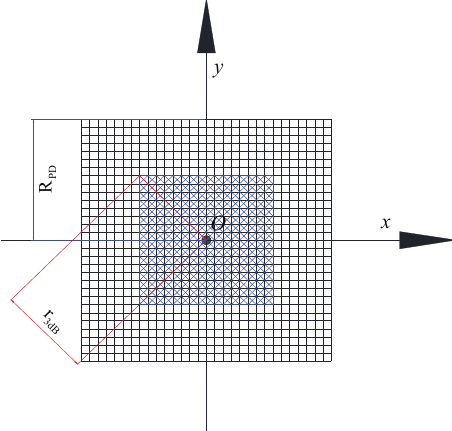
Figure 2. Schematic of optical intensity distribution and 3 dB OISR.